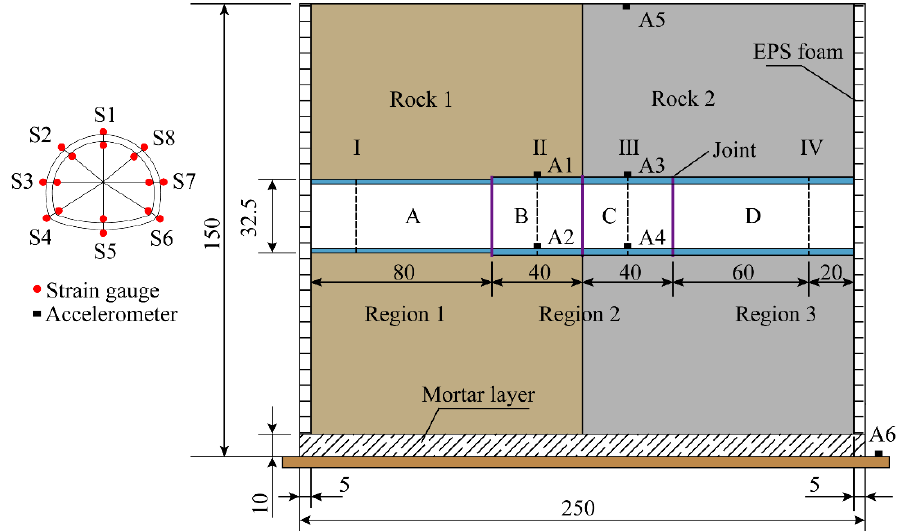
Figure 11. Instrumentation for the shaking table tests.